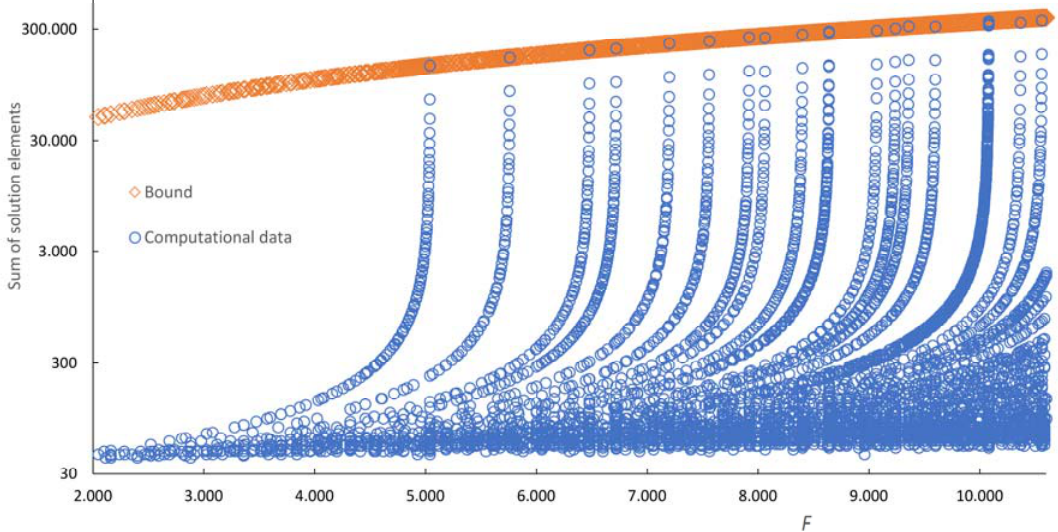
x i = F ∑ 8 x i with x i , F ∈ Z + for distinct-term solutions is i = 1 i = 1